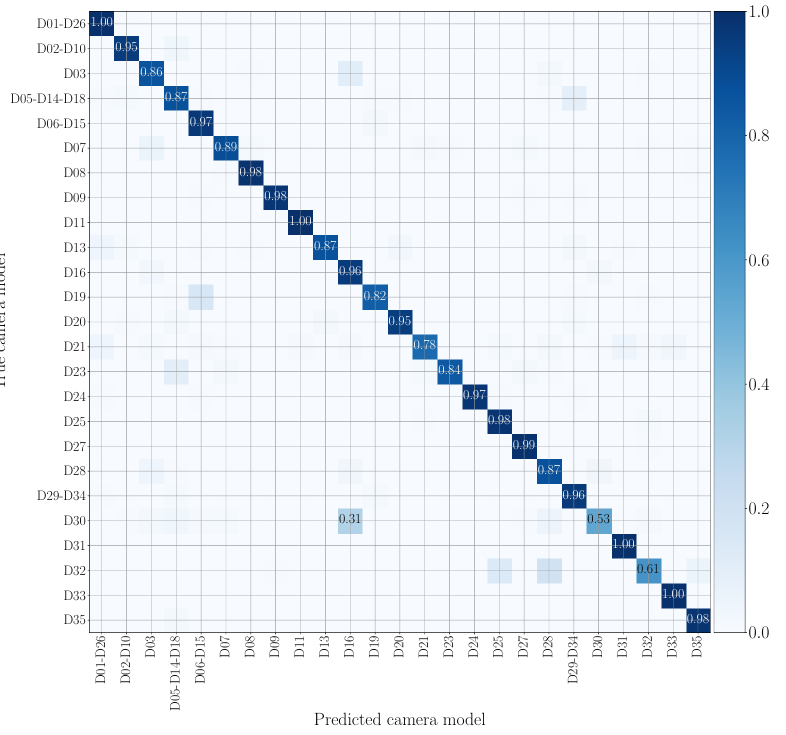
Figure 12. Confusion matrix achieved by multi-modal camera model identification exploiting Late Fusion EV. We report results by training and testing on the native video set, and we only show the numbers which exceed 0.3. Device nomenclature is that of